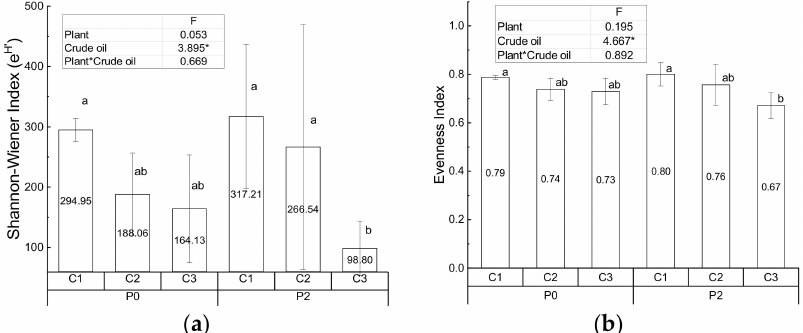
Figure 3. Exponential Shannon-Wiener index ( a ) and Evenness Index ( b ) of controls and treatments. (* indicates the significant di ff erence at the 0.05 level, and average values are in the center of column (calculated from three replicates), meanwhile the error bar of the column is the value of standard deviation. Columns noted by the same and di ff erent small letter means insignificant and significant di ff erence at the 0.05 level,